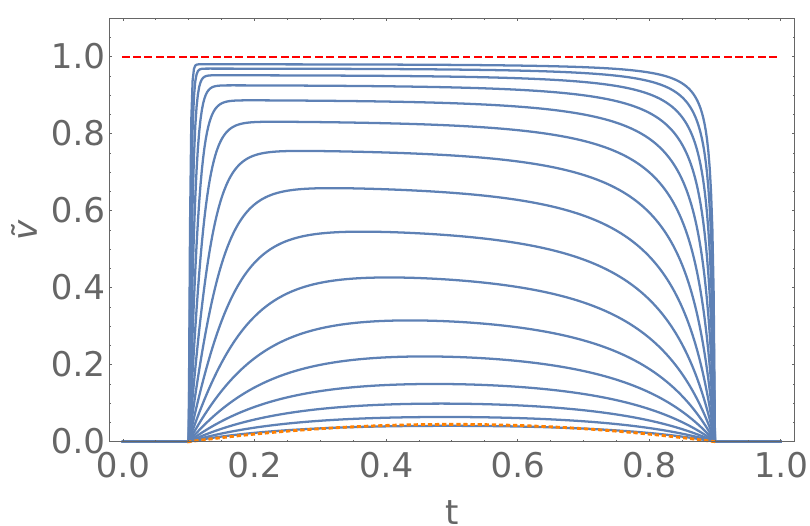
Figure 15 . Entropy increase rates (5.24) for an interval from x min = 0 : 1 to x max = 0 : 9 as a function of time t . We have chosen a (cid:12)xed T R = 1 and T L = 1 + 10 (cid:11) with (cid:11) = (cid:0) 1 ; (cid:0) 0 : 8 ; (cid:0) 0 : 6 ; : : : ; 2, where (cid:11) increases from the lowest solid curve in the (cid:12)gure to the highest one. The dotted (orange) line represents the curve expected from the universal low temperature formula (3.10) for T R = 1 ; T L = 1 : 1. The dashed (red) line signi(cid:12)es the bound